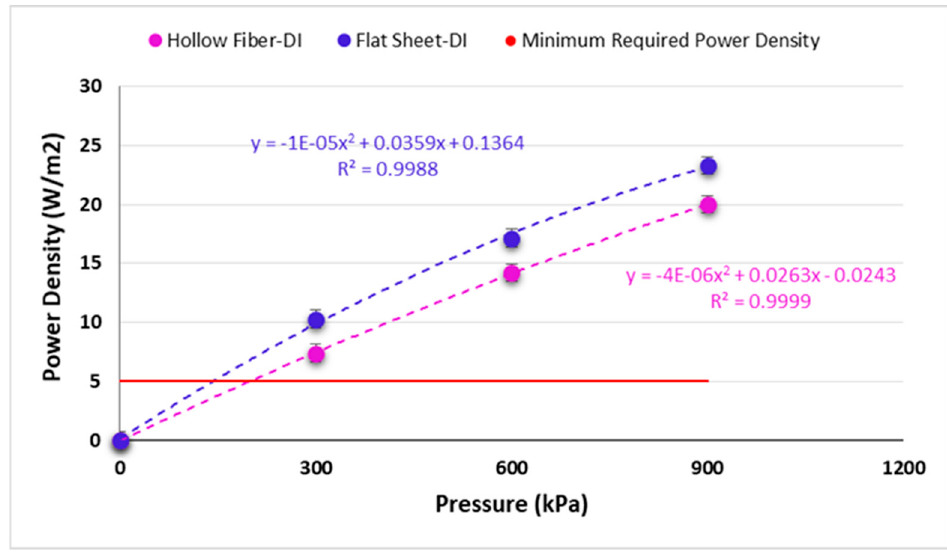
Figure 8. Power density results using two different membrane modules.